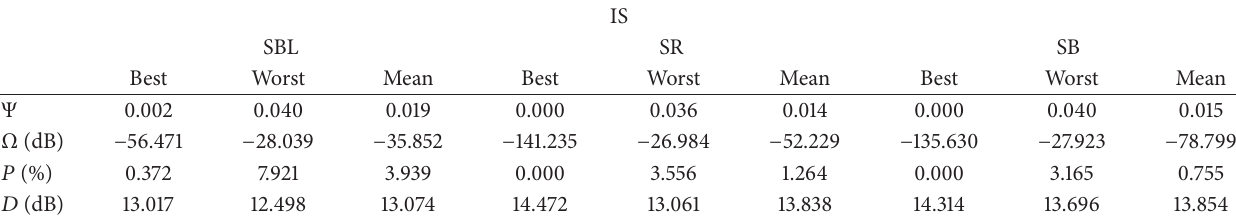
Table 1: Calculated benchmark parameters of DE algorithm outputs for IS.